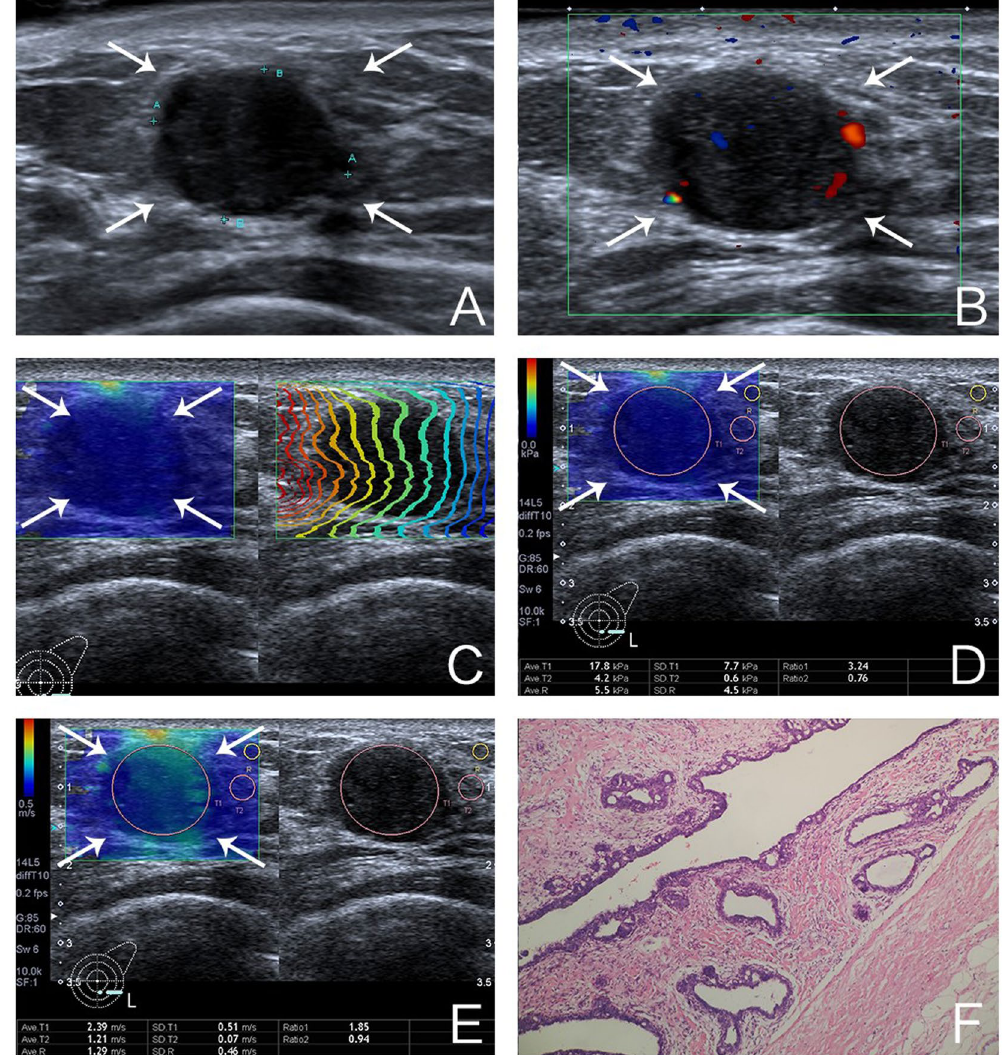
Figure 1. Images of a 31-year-old woman with fibroadenoma. ( A ) The lesion is shown on B-mode ultrasound. ( B ) The lesion is shown on color Doppler ultrasound ( C ) shear wave arrival time contour of the lesion shows regularly parallel lines on the shear wave propagation mode. ( D ) The mean and standard deviation of the lesion on elasticity mode are 17.8 kPa and 7.7 kPa, respectively. ( E ) The mean and standard deviation of the lesion on shear wave speed mode are 2.39 m/s and 0.51 m/s, respectively. ( F ) Pathological examination confirms the diagnosis of fibroadenoma (Hematoxylin-eosin stain; ×